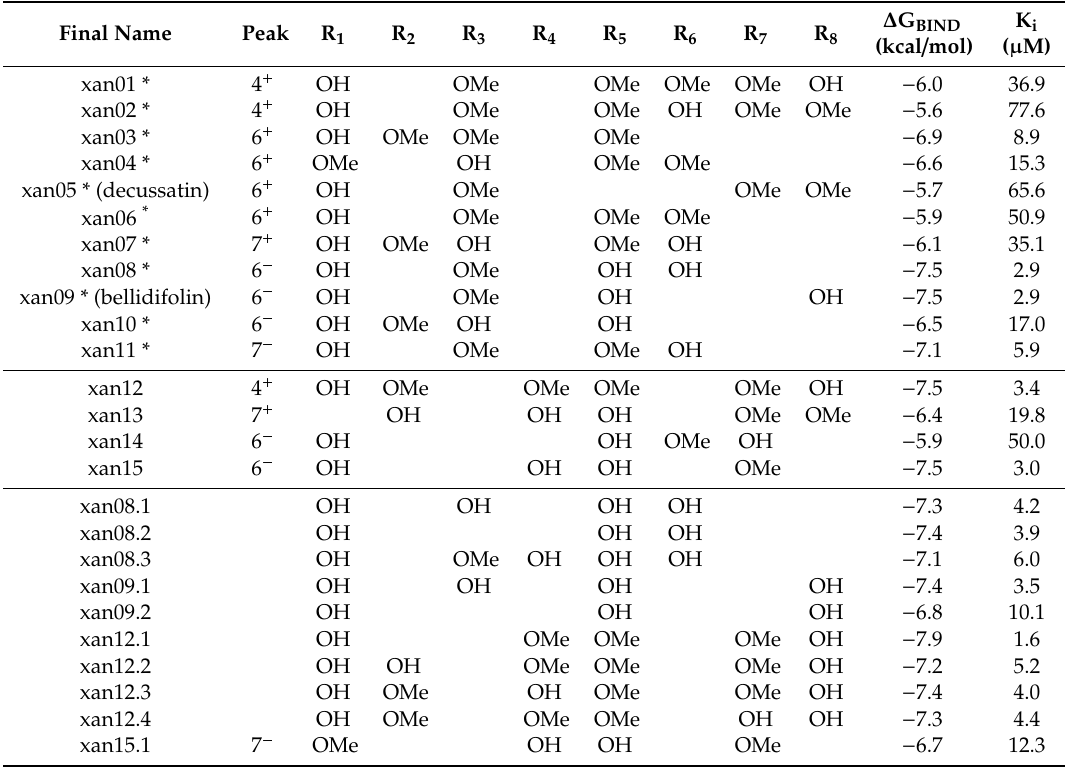
Table 3. Summary of all xanthones used in the AChE molecular docking calculations with their binding energies and inhibition constants. The R1-R8 positions relate to the xanthone template (Figure 3) and the OH / OMe labels refer to the hydroxyl and methoxy groups. The peaks refer to the positive and negative ESI modes in Table